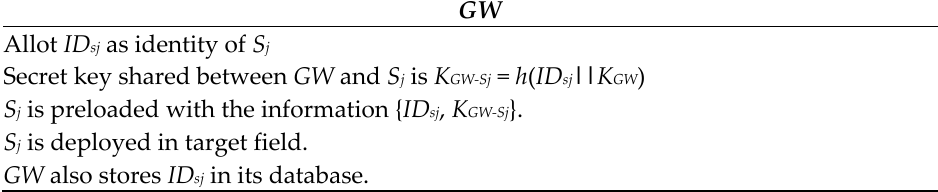
Table 5. Sensor node pre-deployment phase.